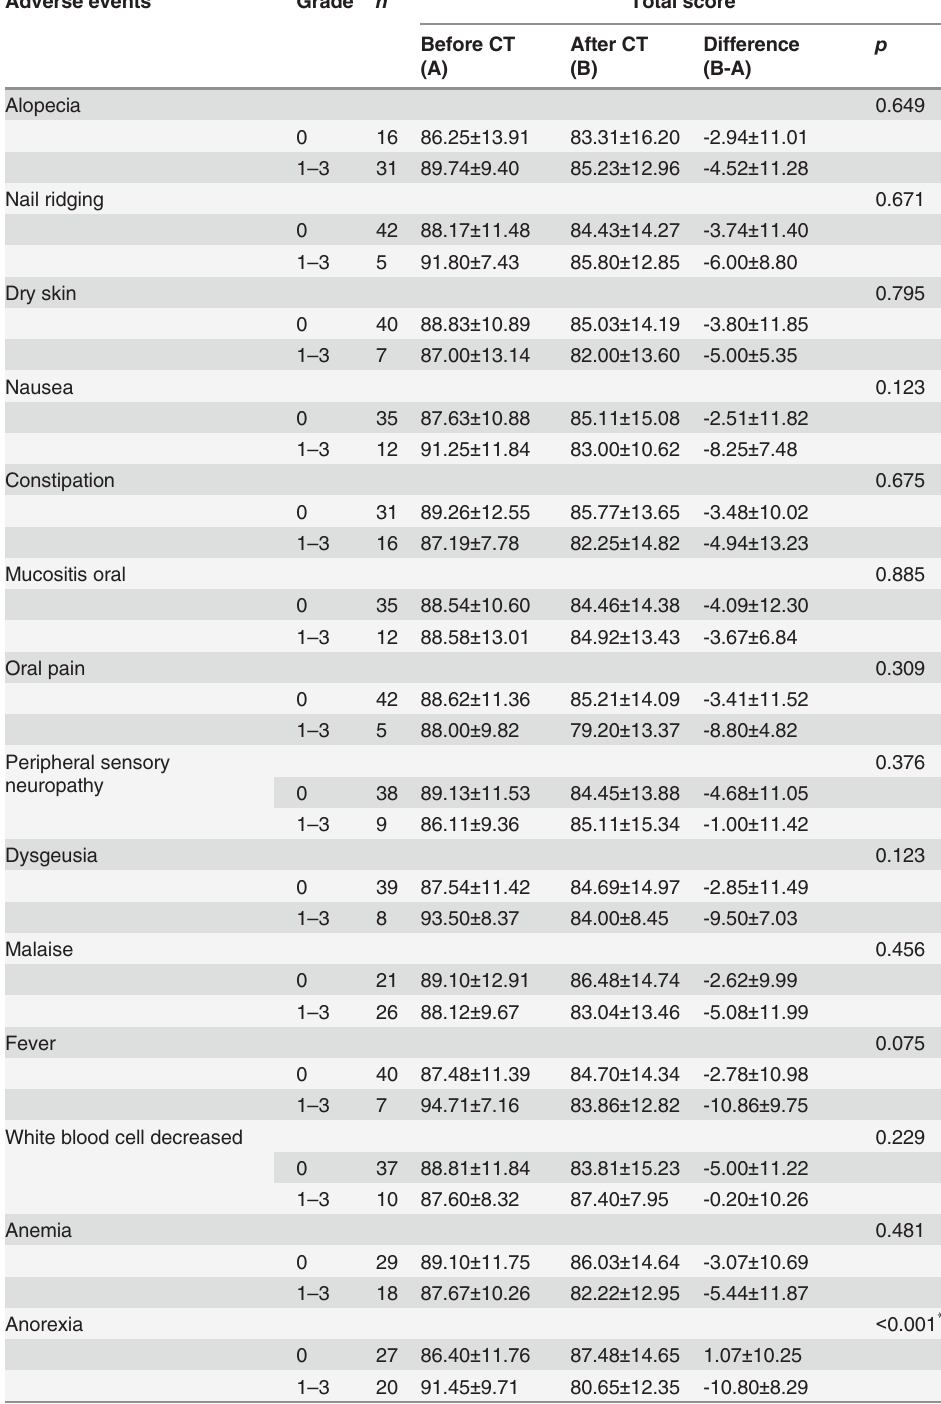
Table 7. Comparison of the QOL-ACD total score for each subscale according to the presence or ab- sence of individual adverse